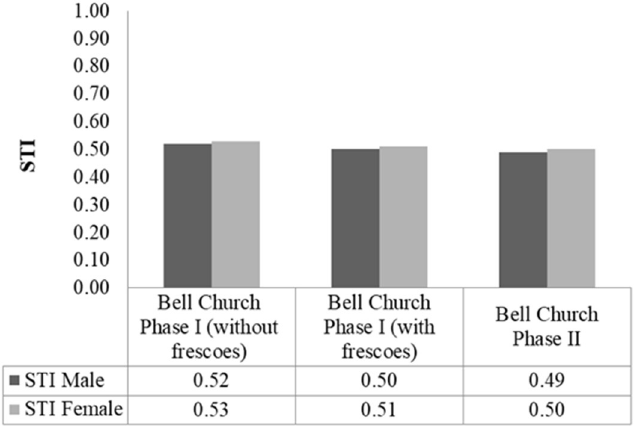
Figure 17. Male and female STIs obtained for Phase I & II of Bell Church. The lowest STI value is 0.49 (STI male, Bell Church Phase II), whereas the highest value is 0.53 (STI female, Bell Church Phase I, without frescoes).